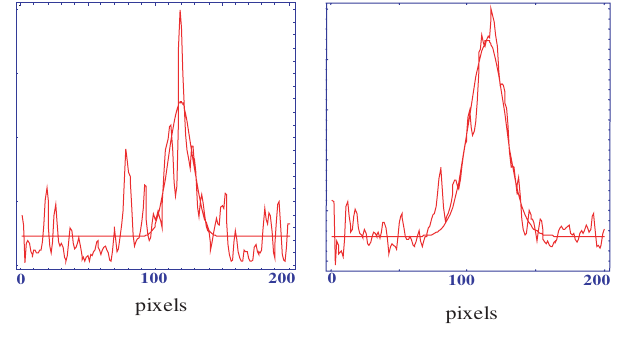
FIG. 9. (Color) Beam profile acquisitions with nitrogen pressure (cid:6) 5 (cid:5) 10 (cid:2) 8 Torr . Beam current (cid:6) 140 mA , energy (cid:6) 14 GeV , and (cid:1) (cid:4) 4 : 7 mm . The Gaussian fit is super- imposed on the experimental data.